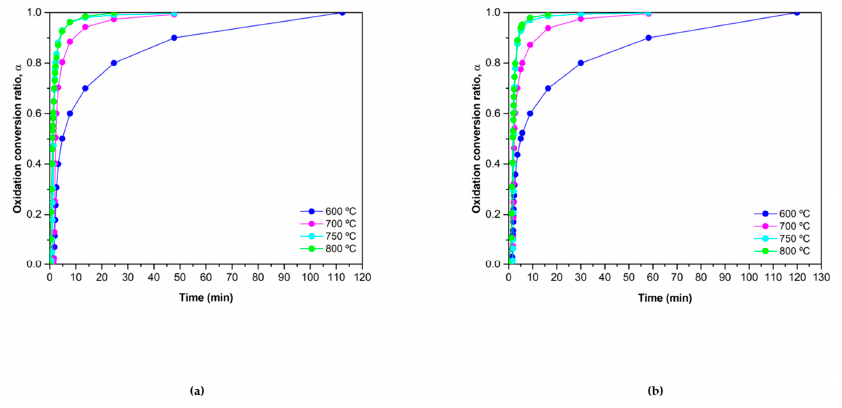
Figure 6. α vs. time plots of the oxidation reaction at p O 2 = 1 of ( a ) Co 2.4 Ni 0.6 O 4 and ( b ) 0.5% SiO 2 /Co 2.4 Ni 0.6 O 4 .